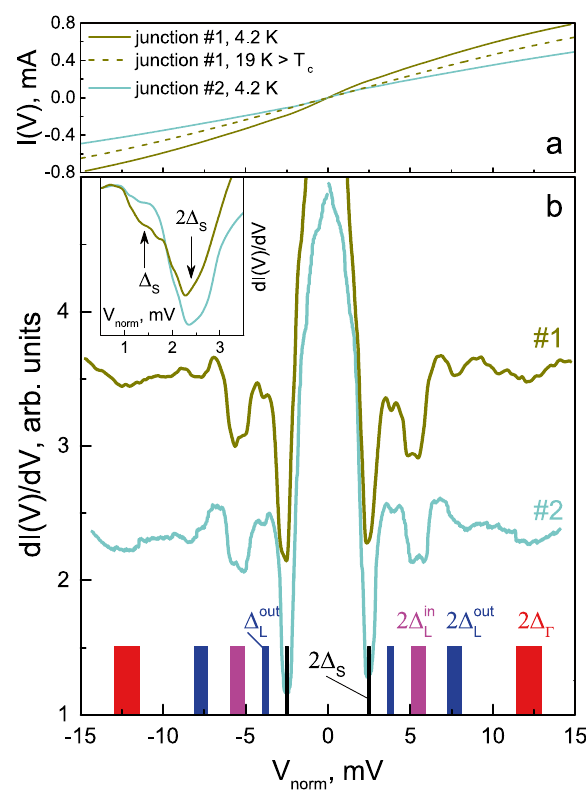
Fig. 1 a Current–voltage characteristics of two SnS-Andreev arrays ( m = 4 and 5 junctions) with T local c ≈ 17.5 K formed in one and the same LiFeAs single crystal at T = 4.2 K. b The correspond- ing dynamic conductance spectra at 4.2 K. Normal-state nonlinear dI(V)/dV background is suppressed. Vertical dashes mark the posi- tions of Andreev features of three possible superconducting order parameters: the large gap Δ Γ ≈ 6.1 meV, the second, anisotropic gap with the edges Δ out L ≈ 3.8 meV and Δ in L ≈ 2.7 meV, and the small gap Δ S ≈ 1.25 meV. The inset shows the low-bias fragments of these dI(V)/dV spectra with additional background suppression in order to reveal some footprints of the second subharmonic of the small gap (arrows, Δ S labels). V norm ≡ V ∕